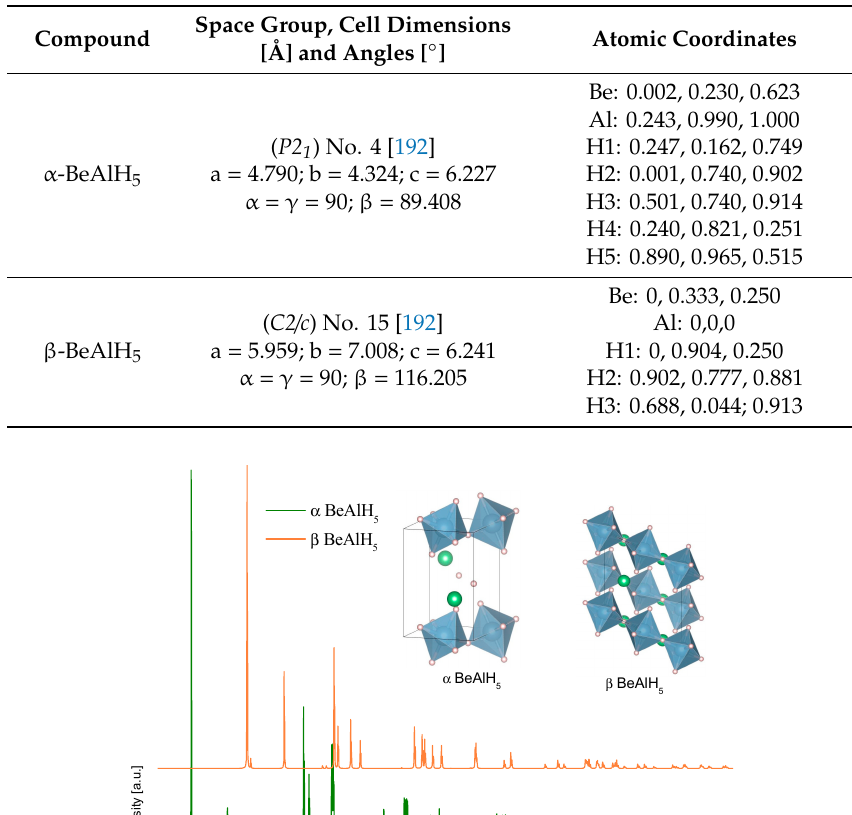
Table 7. Calculated crystallographic data of Be-alanates.